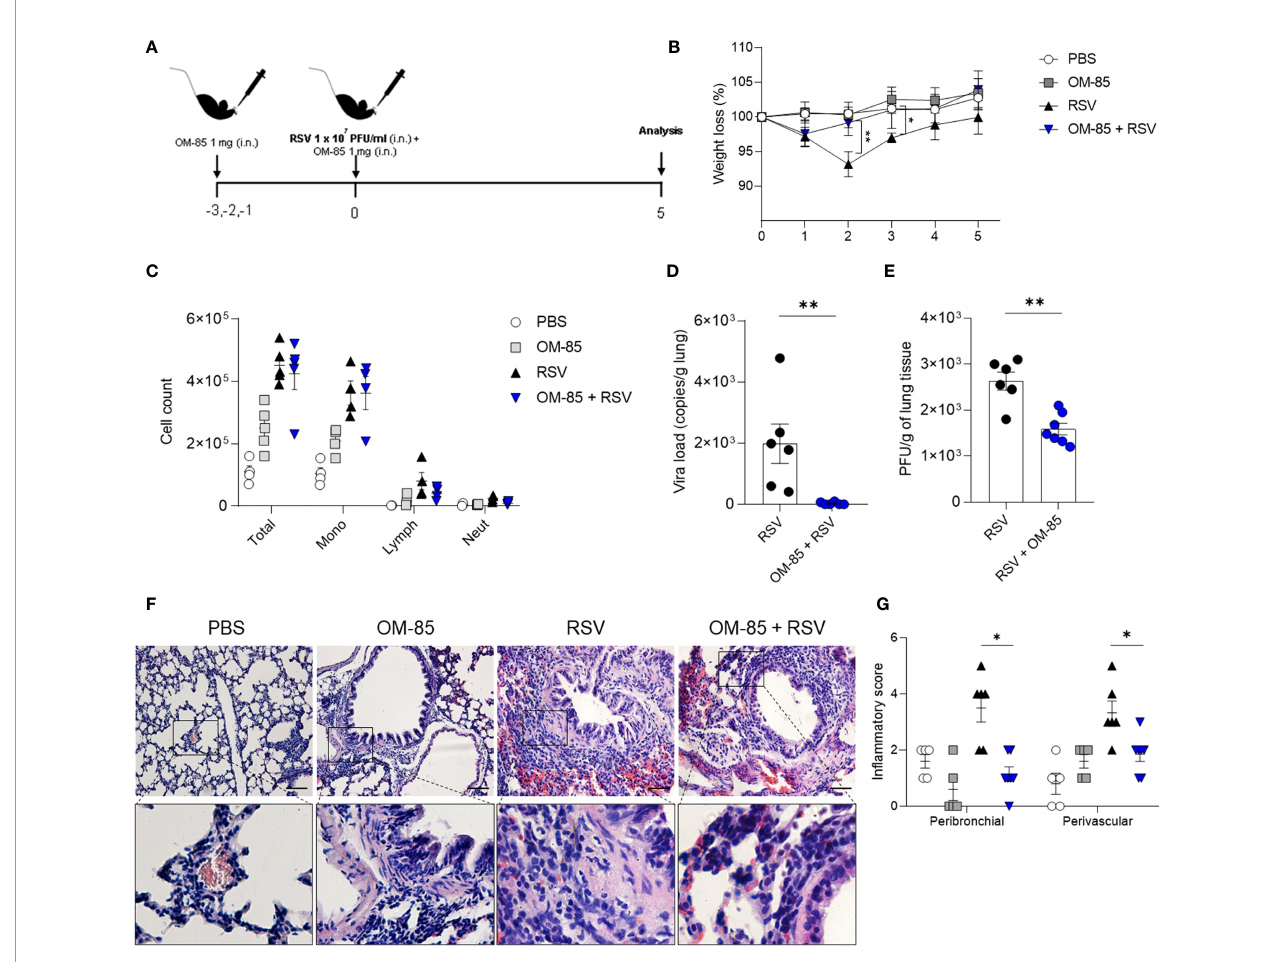
FIGURE 3 | OM – 85 pretreatment starting 3 days prior to infection protects against RSV – induced disease. Mice were treated intranasally with OM – 85 (1mg) 3 days prior to RSV infection. Afterwards, mice were infected with RSV (1x10 7 PFU/ml) and received another OM – 85 boost 6h later. (A) Experimental design. (B) Percentage of weight loss relative to day 0 (right before infection). (C) Total cell number and differential cell counts in BAL. (D) RSV viral load detected in lung tissue by real – time PCR (viral copies/g of lung tissue). (E) Viral titer in the lung (PFUs/g lung tissue). (F, G) Representative images of lung tissue section stained with H&E and its respective in fl ammation scores. Scale bars=200 m m. Data from 2 independent experiments (n = 6 per group). All data are expressed as mean±SEM. Multiple groups were compared using Kruskal – Wallis, except in (D, E) in which the comparison between groups was made using Mann – Whitney test. * p <0.05. ** p